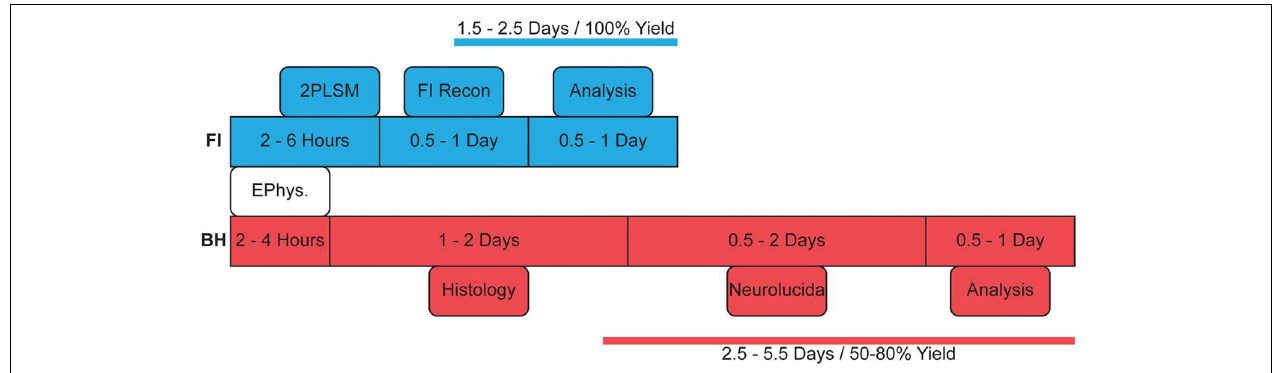
FIGURE 1 | Flowchart indicating typical reconstruction steps with either method. BH reconstructions take longer due to histology and require multiple setups for recording and reconstruction with Neurolucida. As FI can be monitored online during 2PLSM image